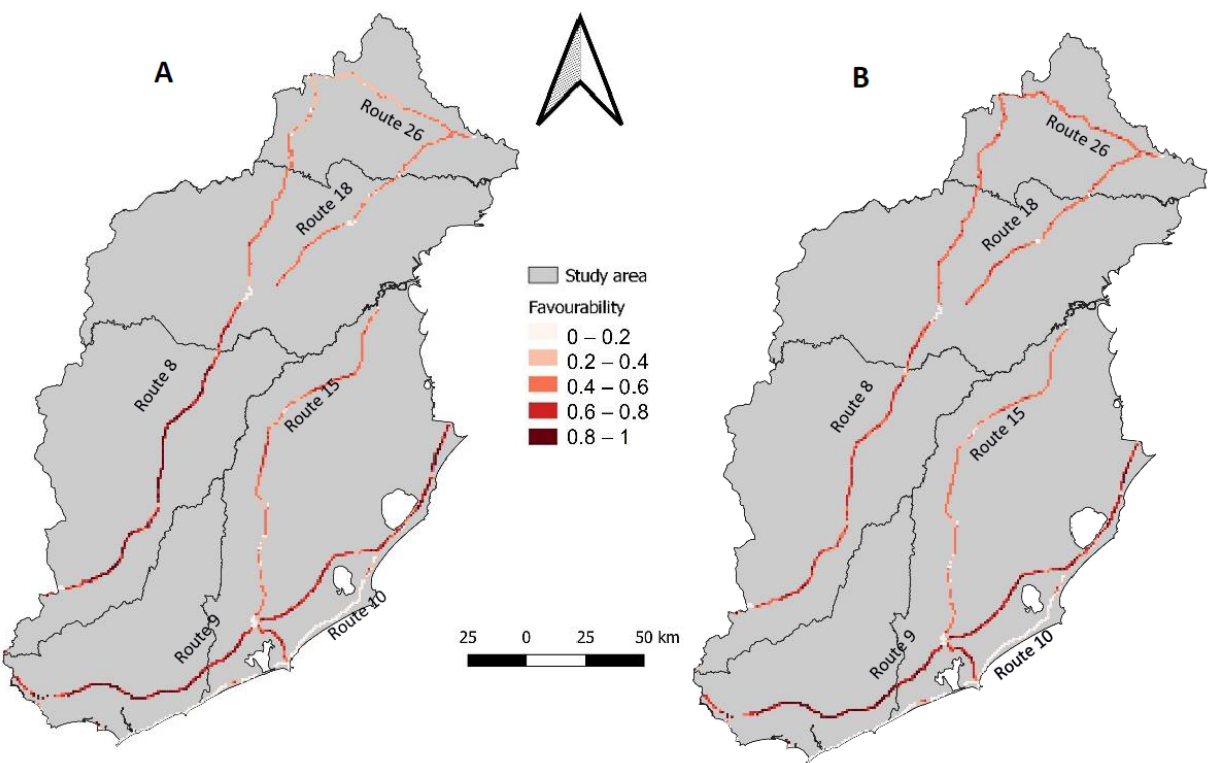
Figure 4. Models obtained for grassland species. ( A ) Model with the 3 factors (climatic, geographic, and anthropic), ( B ) Model with the anthropic factor.